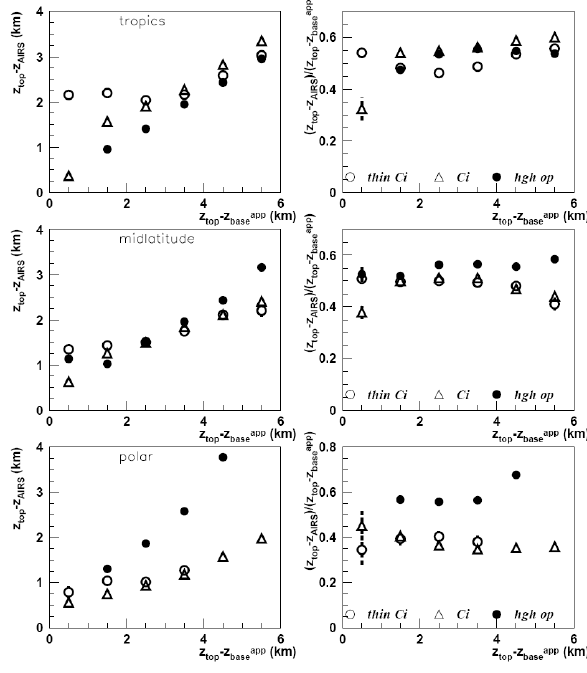
Figure 12: Average difference between cloud top and height of maximum backscatter (right panels) and average difference relative to ‘apparent’ cloud geometrical thickness (left panels) as a function of ‘apparent’ cloud geometrical thickness, separately for high opaque clouds (full circles), cirrus (open triangles) and thin cirrus (open circles) and for three different latitude bands: 30°N-30°S (upper panels), 30°-60° (middle panels) and 60°-90° (lower panels).